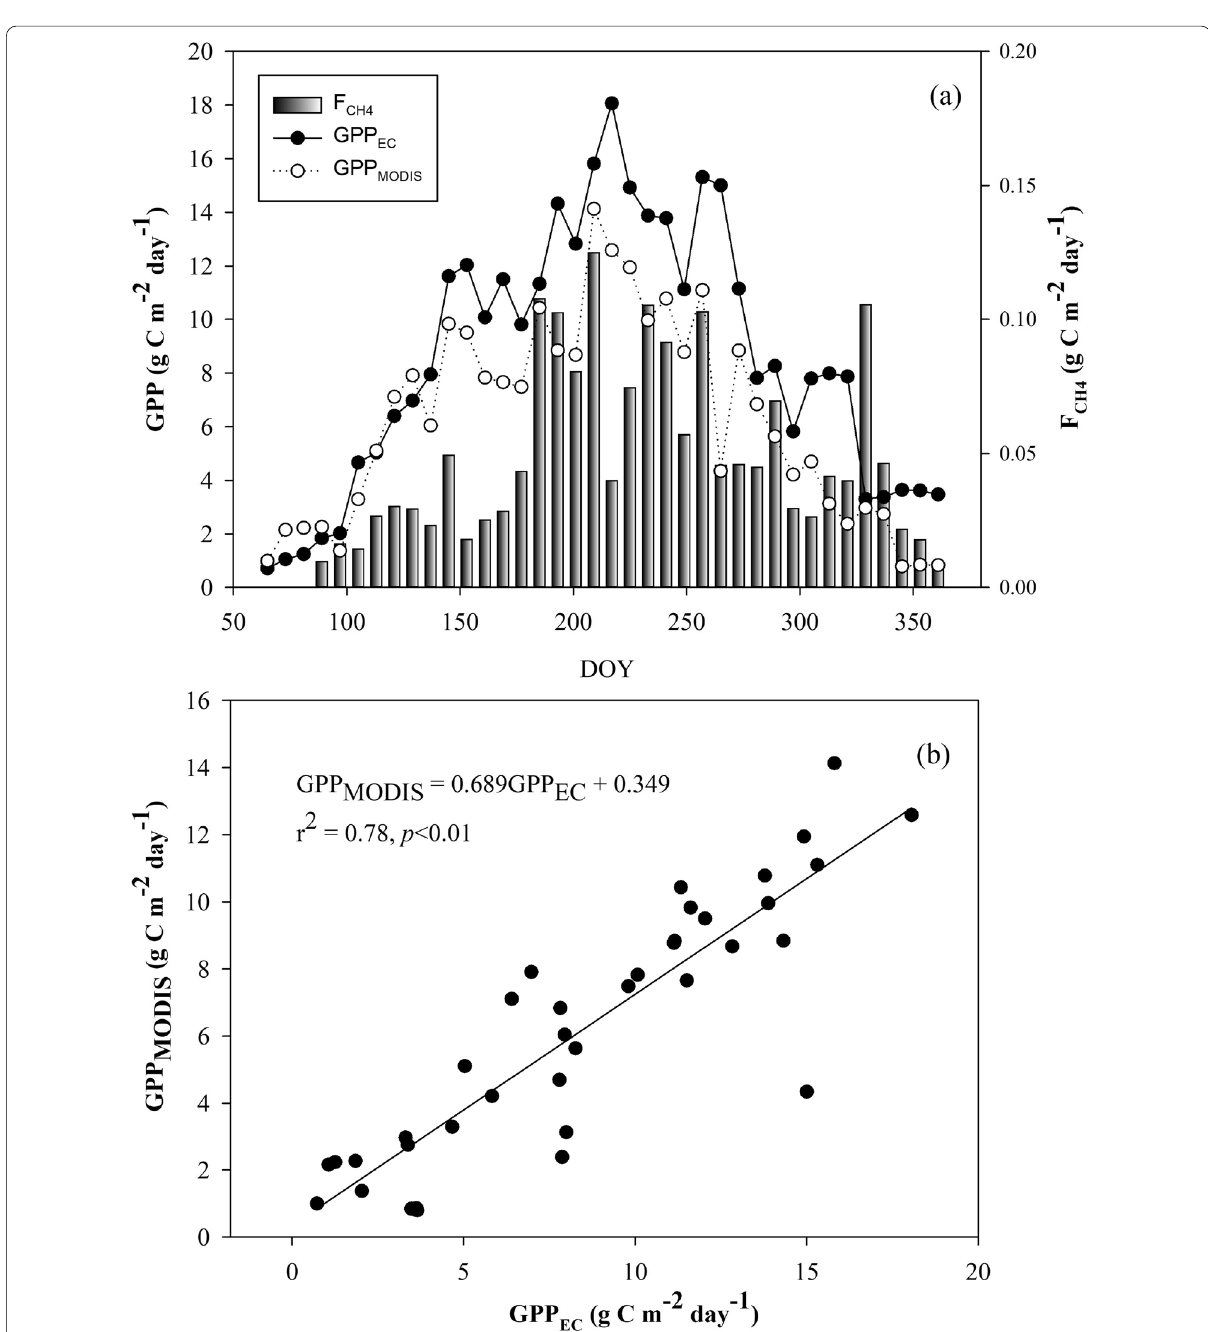
Fig. 3 Seasonal changes in gross primary production from eddy covariance towers (GPP EC ), MODIS-based GPP (GPP MODIS ), and net ecosystem exchange of CH 4 (F CH4 ) (DOY equals day of year) ( a) and the linear relationship between GPP EC and GPP MODIS ( b ). GPP EC and GPP MODIS were estimated during the 2010 growing